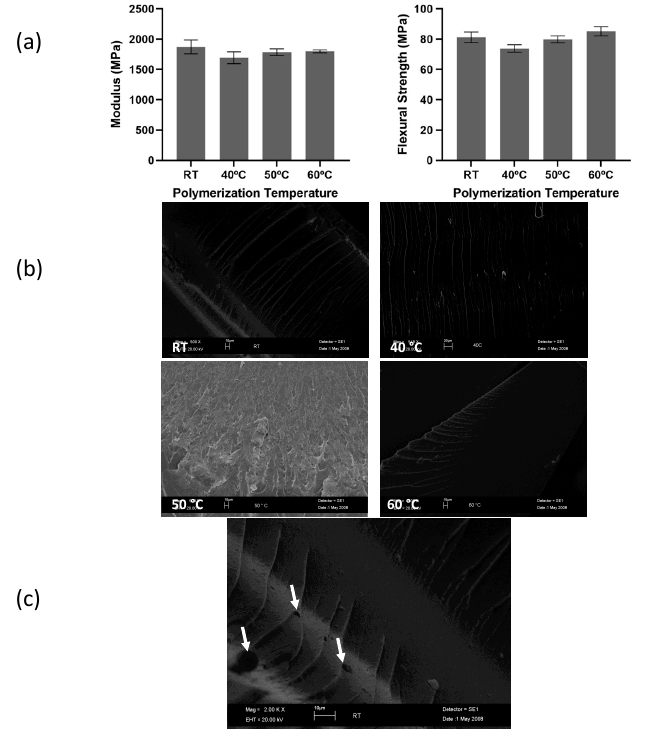
Figure 4. Mechanical properties and fracture surfaces of P(tBC6DA). ( a ) modulus (left) and flexural strength (right) of P(tBC6DA), ( b ) SEM fracture surfaces of P(tBC6DA) at different test temperatures, ( c ) higher magnification fracture surface of P(tBC6DA-RT) under SEM detailing void structure (small arrows) and general direction of crack growth toward the branching direction of the river lines (long arrow) at border between widely separated/narrowly separated river pattern. Data are presented as mean with SD.